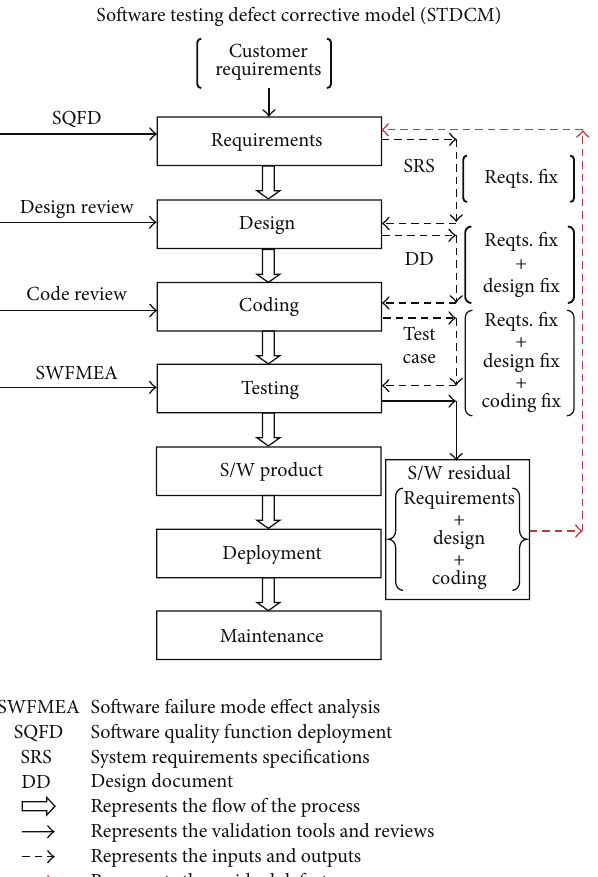
Figure 3: Framework of the software testing defect corrective model